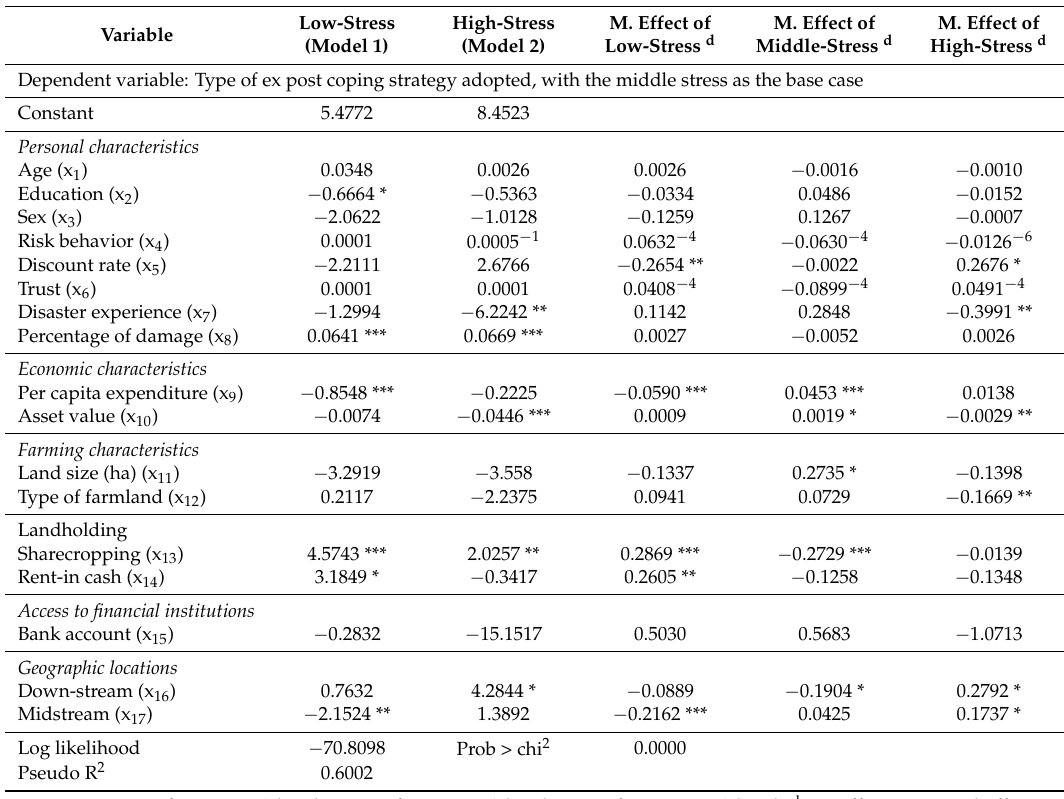
Table 10. Estimated coefficients and marginal effects of the multinomial logit